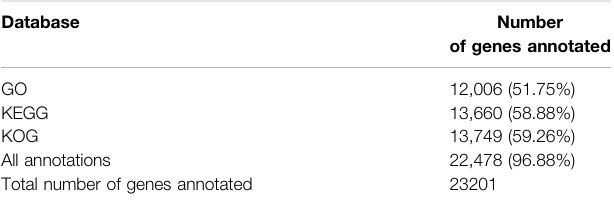
TABLE 5 | Functional annotation of genes using protein databases.